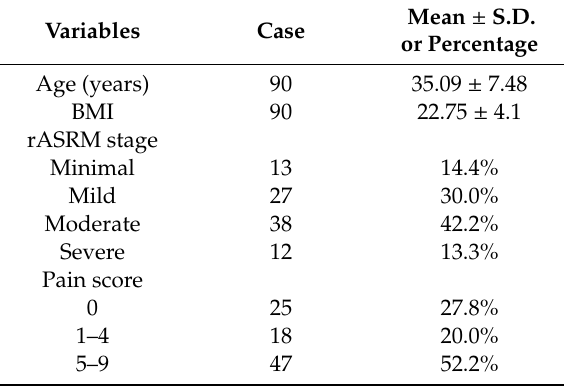
Table 1. Demographic data of endometriosis